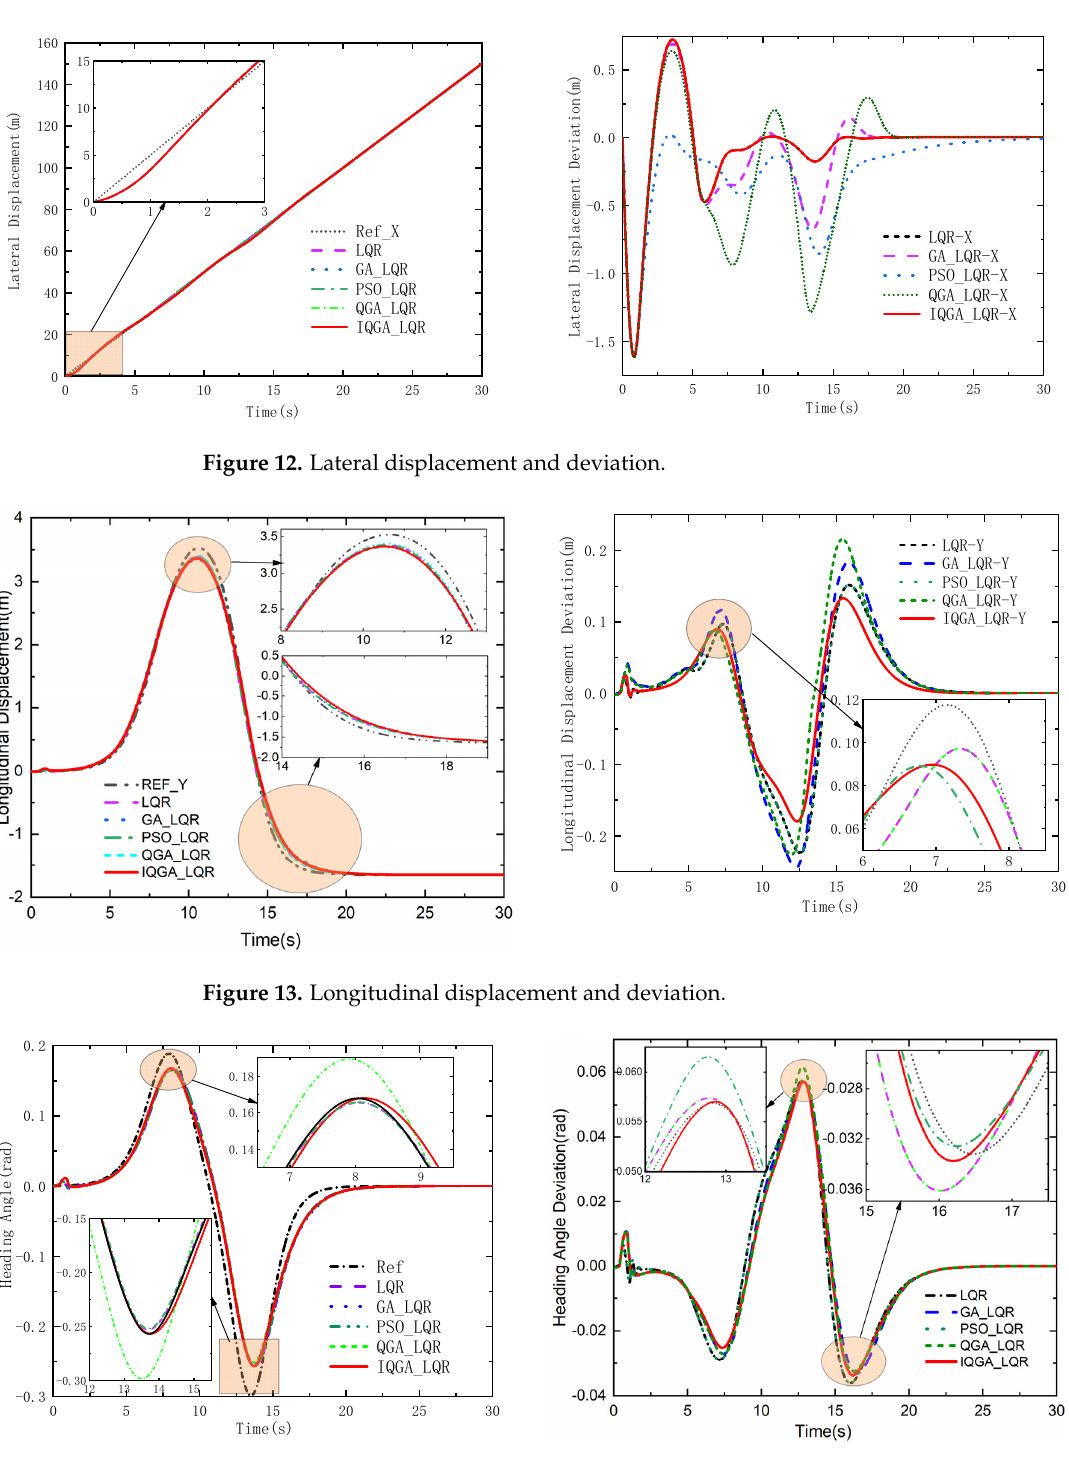
Figure 14. Heading angle and deviation.